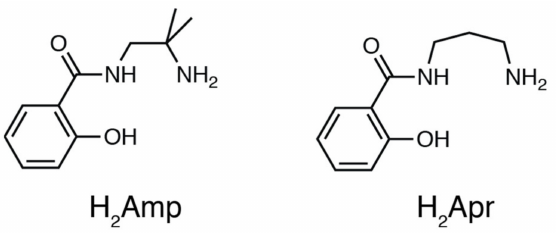
Figure 1. Chemical structures of ligand precursors H 2 Amp and H 2 Apr.